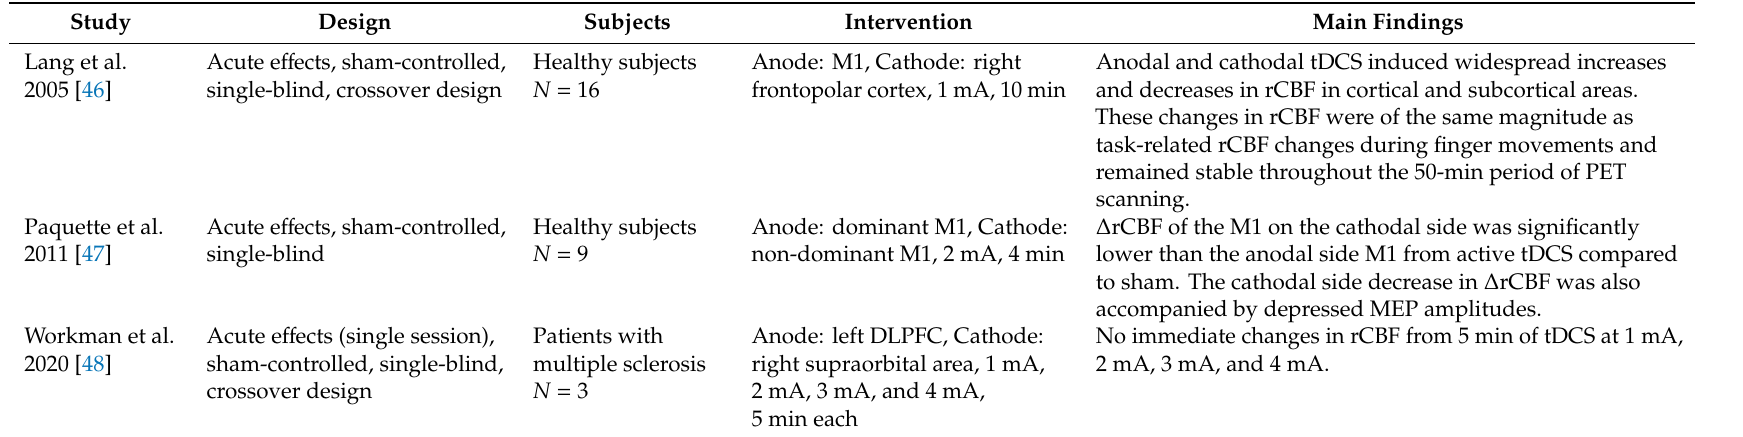
Table 2. Summary of studies that investigated the e ff ects of transcranial direct current stimulation (tDCS) with [ 15 O]water